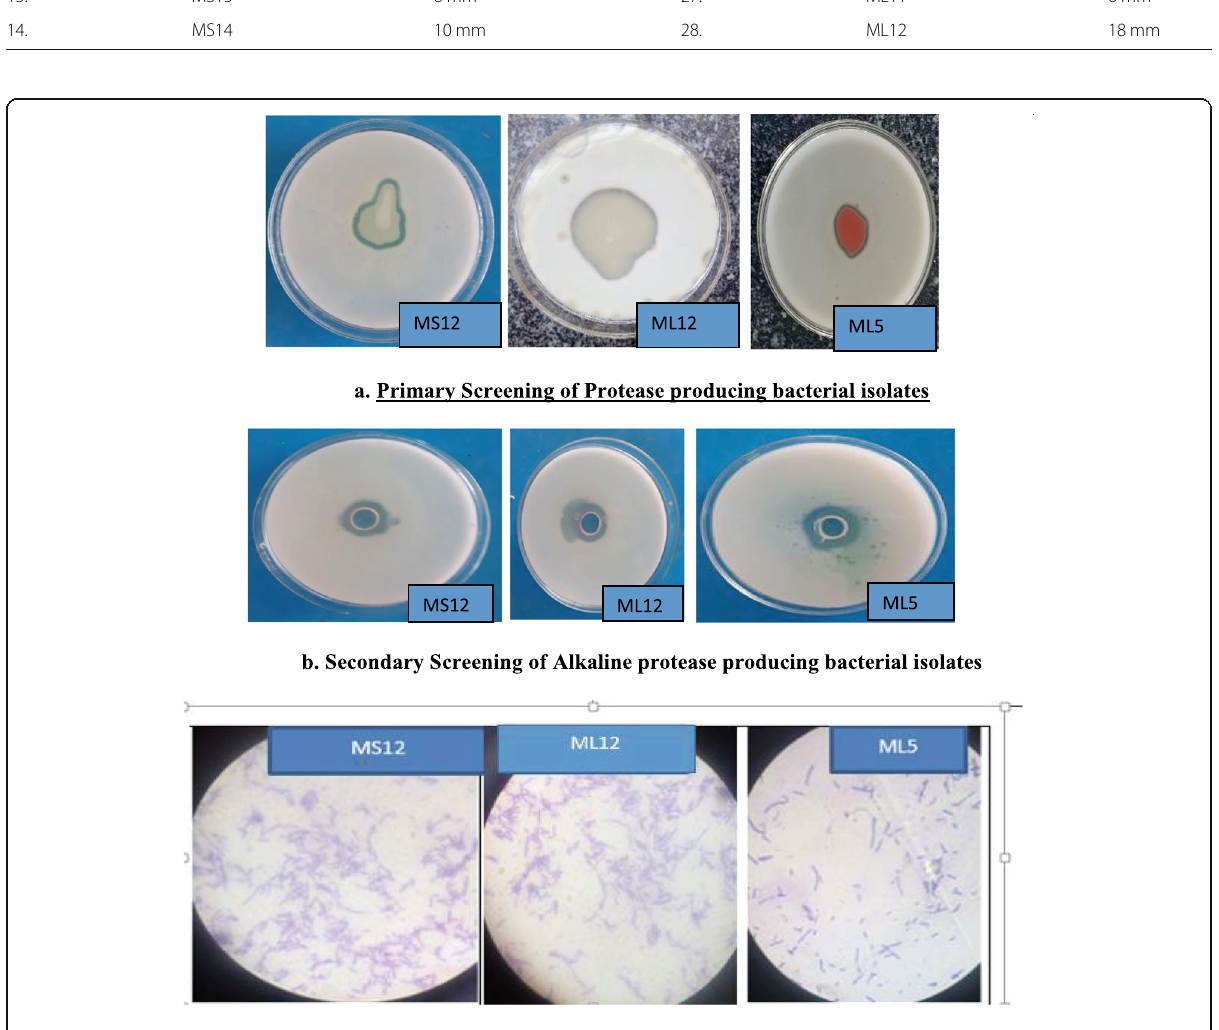
Fig. 3 a Primary screening of protease producing bacterial isolates. b Secondary screening of alkaline protease producing bacterial isolates. c Gram staining of selected alkaline protease-producing bacterial